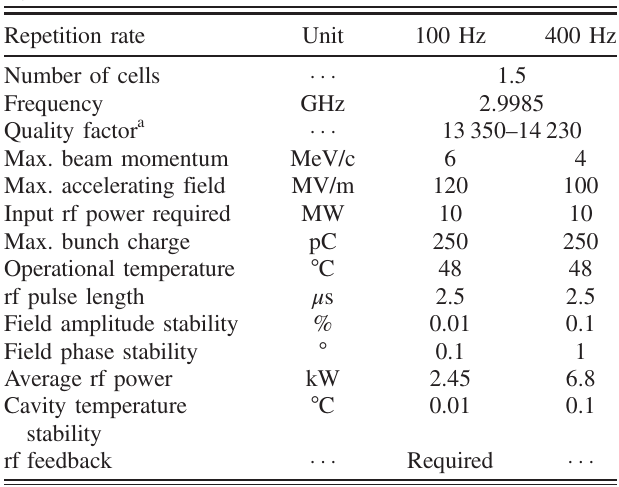
TABLE IV. Table of design parameters for the 400 Hz photo- injector.